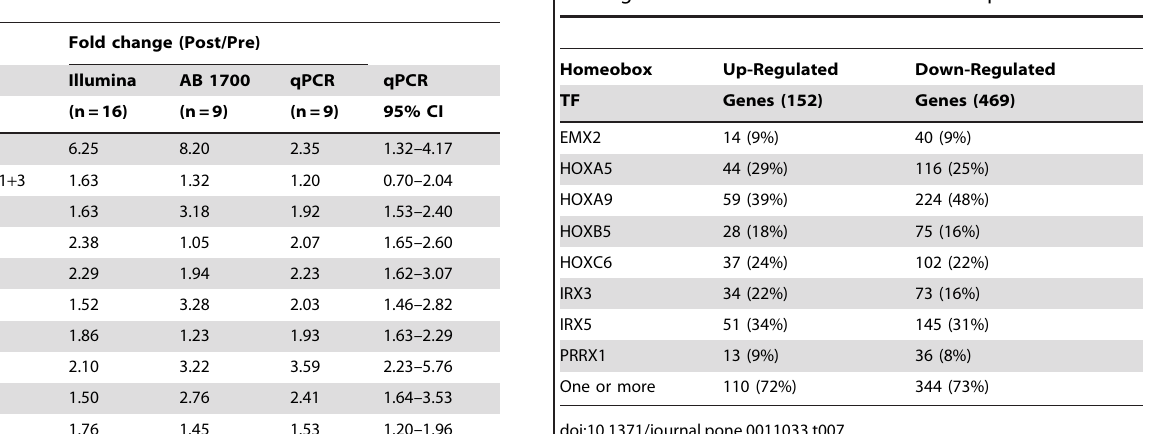
Table 7. Number of differentially expressed genes with binding sites for selected homeobox transcription